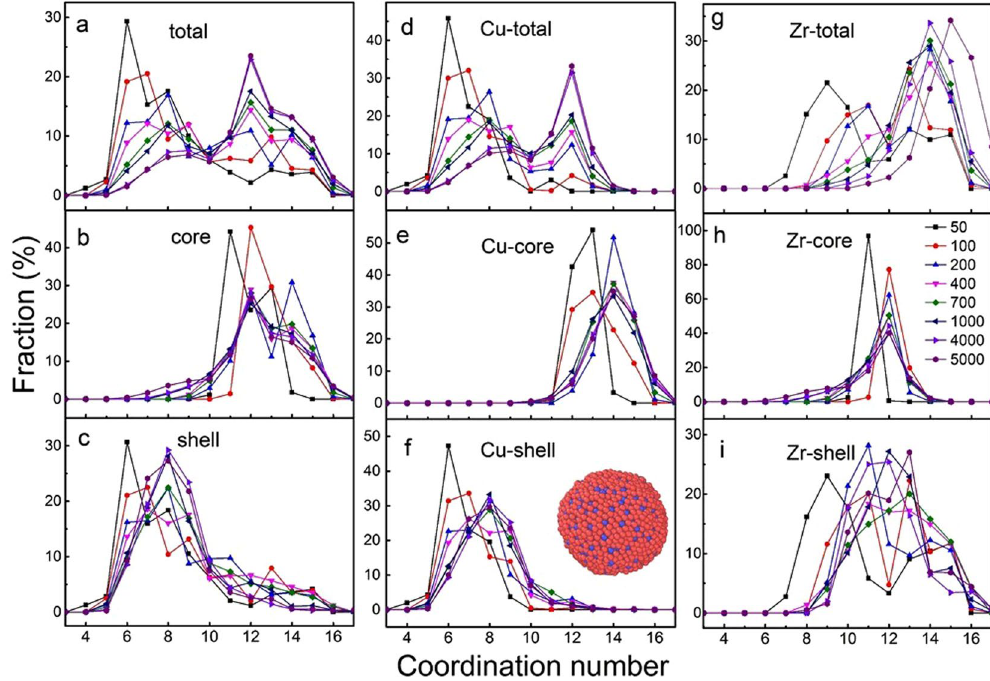
Figure 3. The coordination number distributions of the total sample, core and shell components, ( a–c ) for both elements, ( d–f ) for only Cu-centered atoms, and ( g–i ) for only Zr-centered atoms, respectively. The inset in ( f ) is the 5000-atom particle with red balls as Cu atoms and blue balls as Zr